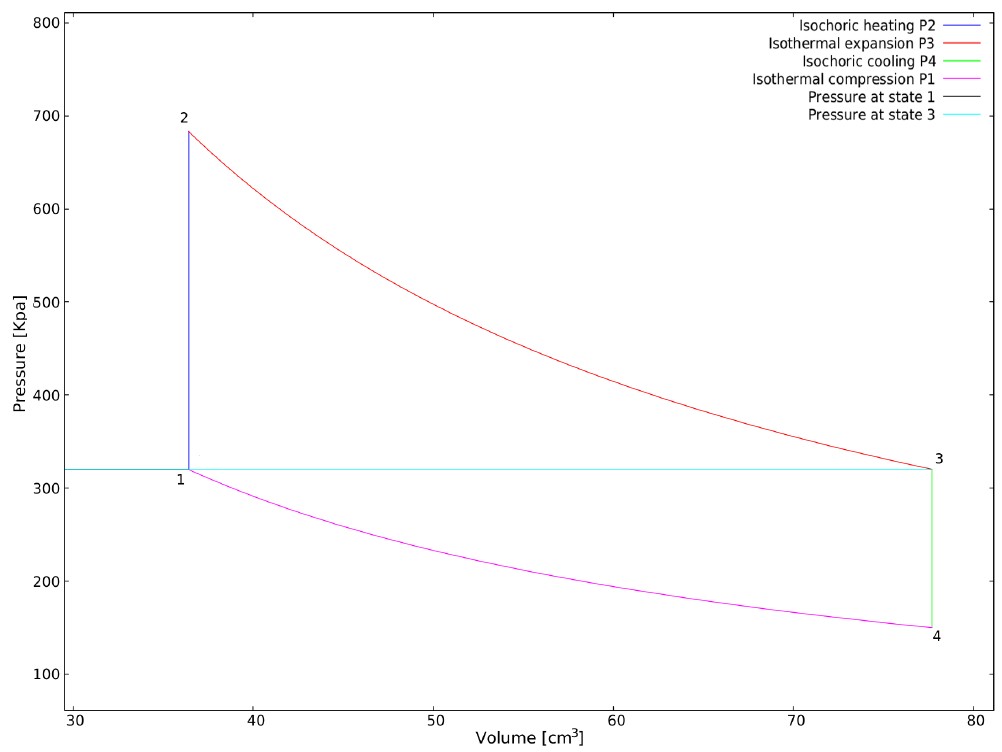
Figure 8. The ideal CR for the proposed beta